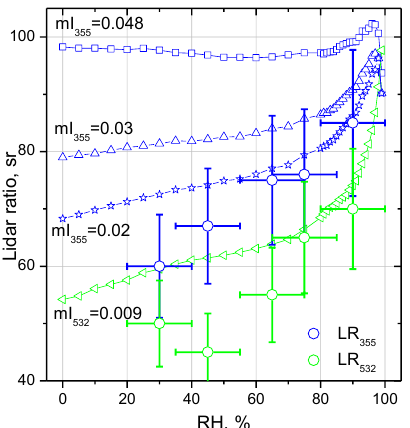
Figure 4. Lidar ratios LR 355 and LR 532 for five dust – smoke episodes (open symbols) together with simulated values (line + symbols). In simulation, three values of imaginary part of dry particles at 355 nm are considered: m I =0.048, 0.03, and